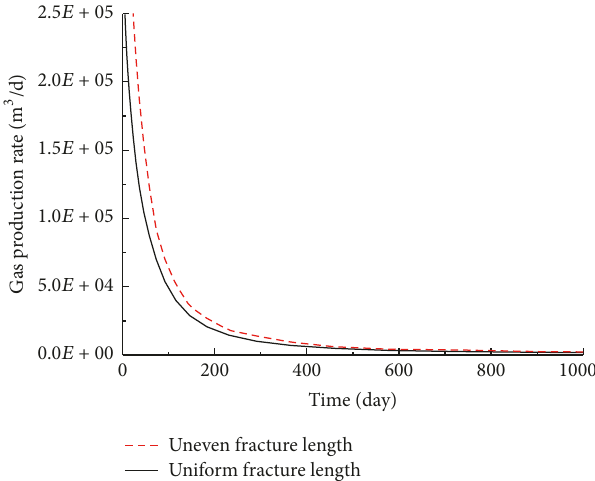
Figure 9: Effect of fracture uniformity on gas production rate.